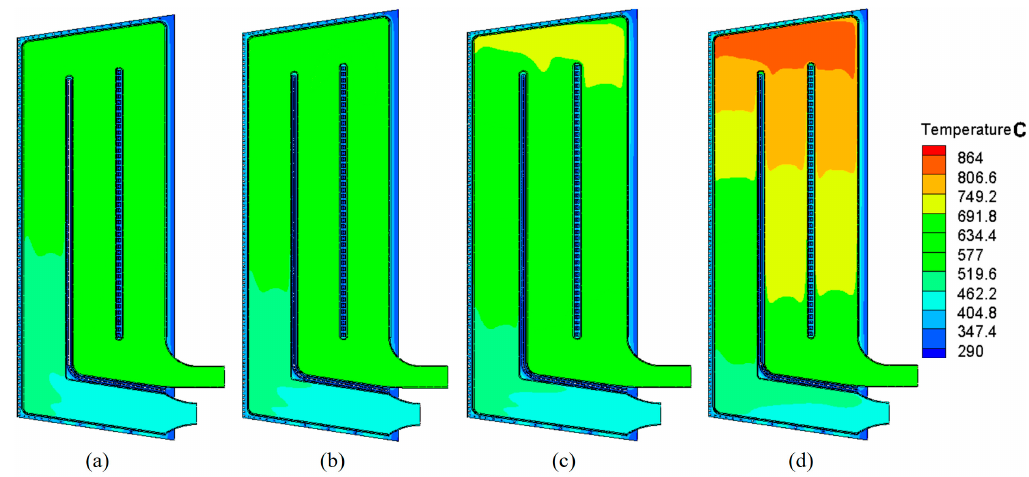
Figure 14. Variation of pressure drop versus different coolant inlet velocity.